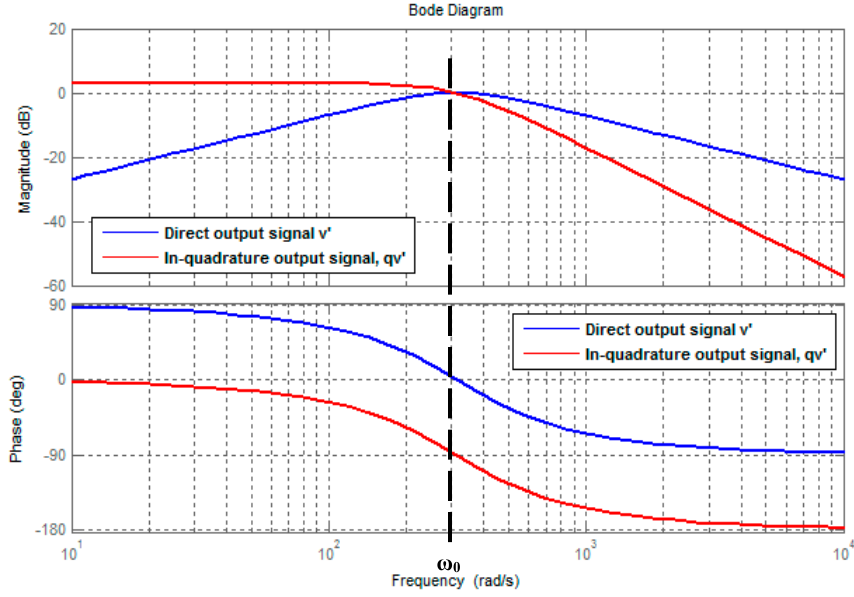
Figure 3. Bode diagram of SOGI-QSG block.